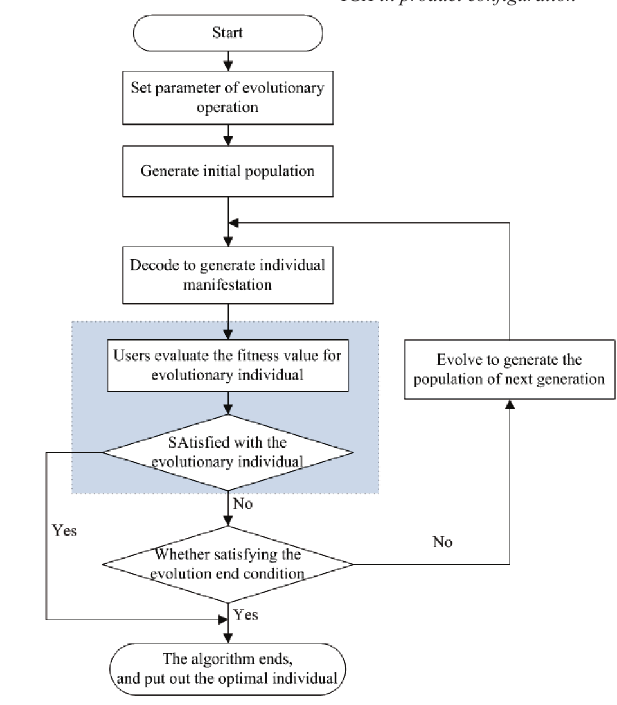
Fig.2. Traditional